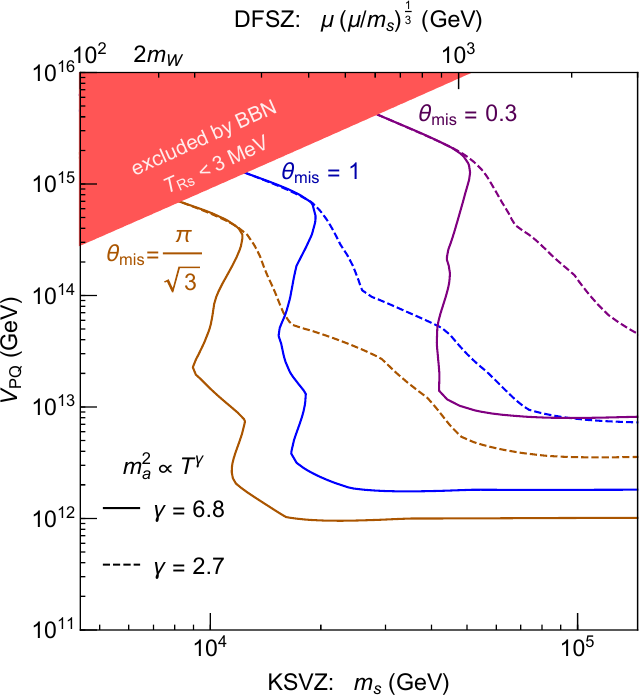
Figure 1 . Contours of the axion abundance, (cid:10) a h 2 = 0 : 11, from vacuum misalignment and dilution from decay of the saxion condensate in DFSZ with m s > 2 m h (upper axis) and KSVZ (lower axis) theories. Here we set N DW = 1. The solid (dashed) lines refer to di(cid:11)erent temperature dependence of the axion mass, (cid:13) = 6 : 8 (2.7), as estimated by the lattice QCD